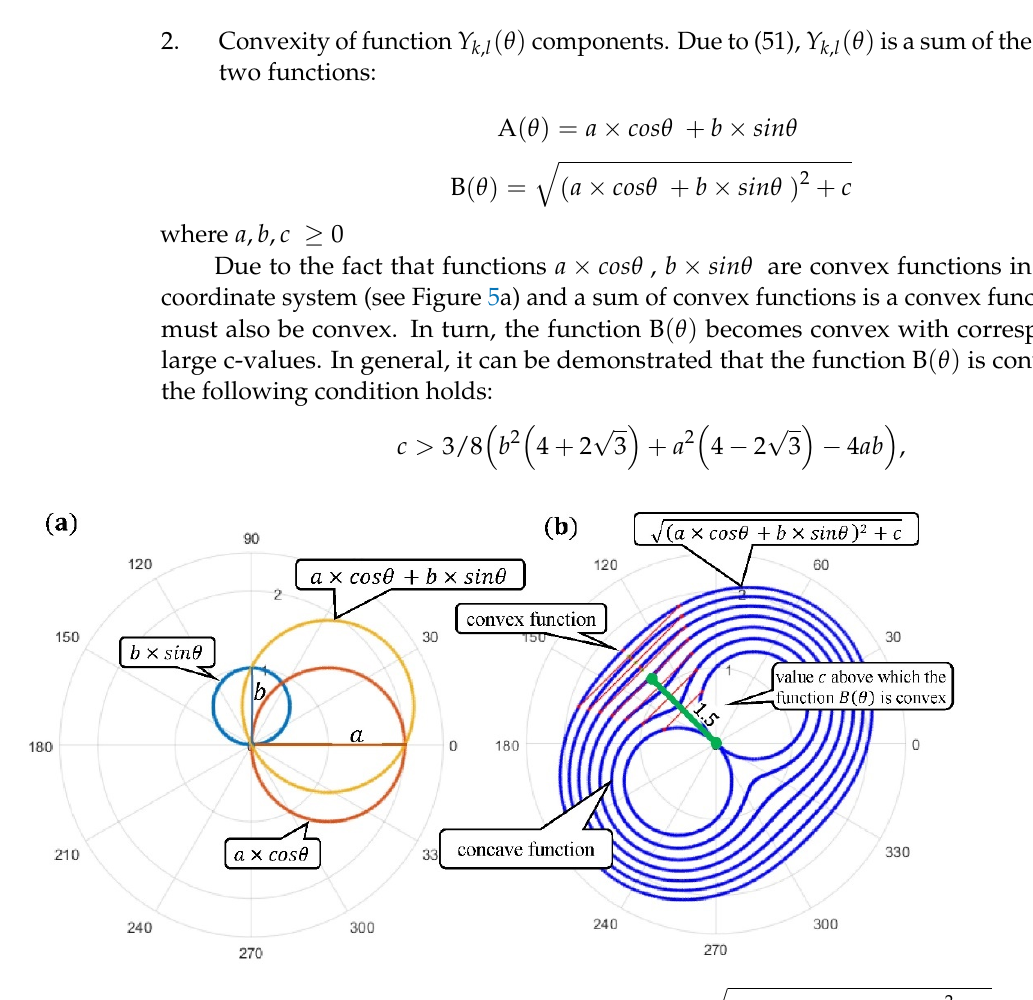
Figure 5. Function charts: ( a ) A ( θ ) = a × cos θ + b × sin θ and ( b ) B ( θ ) = (cid:3493)(cid:4666)𝑎 (cid:3400) cos𝜃 (cid:3397) 𝑏 (cid:3400) sin𝜃 (cid:4667) (cid:2870) (cid:3397) 𝑐 .